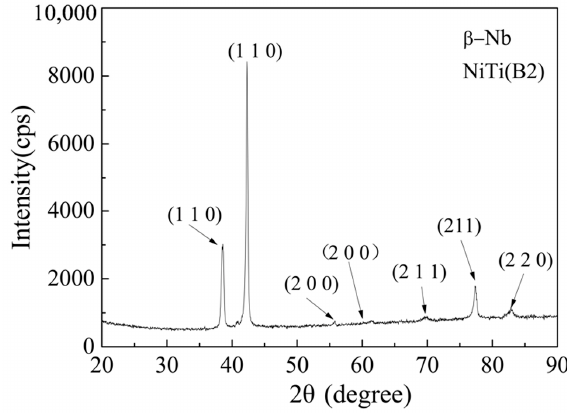
Figure 1. XRD map of as-rolled NiTiNb SMA.